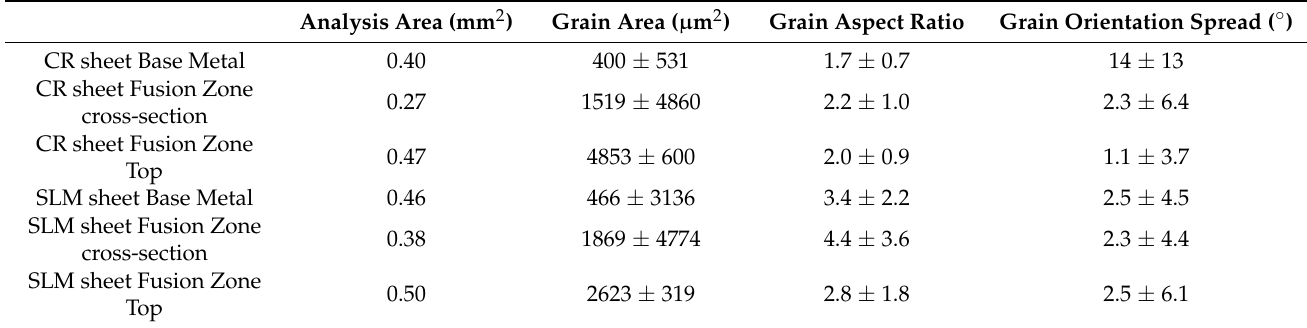
Figure 5. Pole figures of the crystallographic planes (001), (011), and (111) for the fusion zone and base metal of a welded cold-rolled sheet ( a ) and a welded SLM sheet ( b ), respectively. Although the CR sheet BM consisted of equiaxial non-textured twined austenitic grains, the SLM BM microstructure was close to the SLM FZ microstructure. This result was confirmed by the similar pole figure (Figure 5b). Moreover, the pole figure of the fusion zone indicates a similar texture for both samples (CR and SLM). From the EBSD maps, some morphological parameters of the grains were extracted (cf. Table 8). Table 8. Summary of some microstructural characteristics: average grain diameter, grain shape aspect ratio, and average Grain Orientation Spread (GOS).